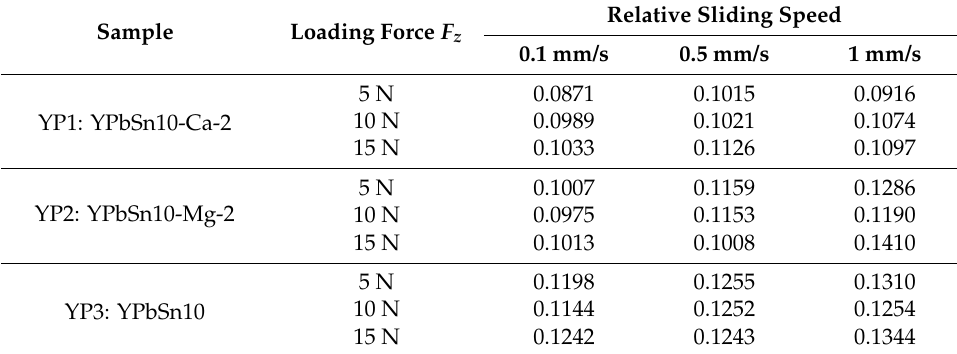
Table 2. Average value of the friction